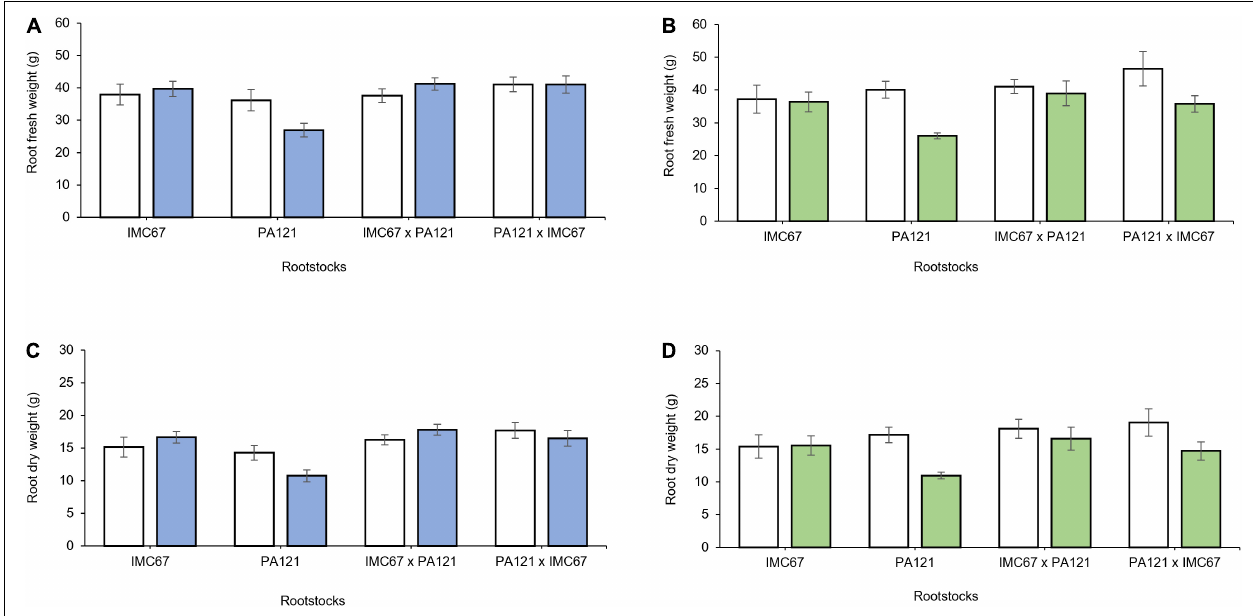
FIGURE 5 | Root biomass of rootstock × scion combinations 2 months after grafting seedling rootstocks subjected to two different concentrations of Cd in soil under greenhouse conditions. Panel (A,B) depict fresh root weight of rootstock families having ICS95 and CCN51 as scions. Panel (C,D) show dry root weight of OP and full-sib rootstock progenies having ICS95 and CCN51 as scion. White bars represent rootstocks grown in soil without addition of Cd (0.43 mg kg − 1 ). Blue bars represent rootstocks grown in Cd spiked soil (7.49 mg kg − 1 ) grafted with the ICS95 clonal scion. Green bars represent rootstocks grown in Cd spiked soil (7.49 mg